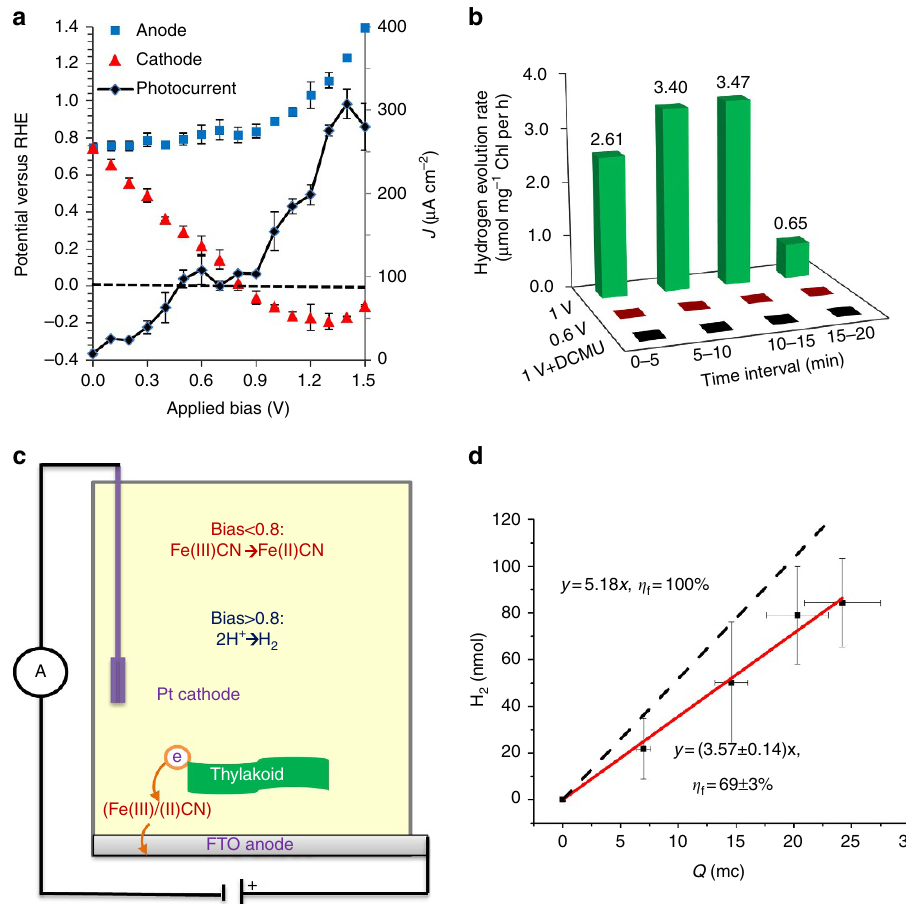
Figure 6 | Two-electrode mode measurements. ( a ) Photocurrent (black curve) and anode (blue squares) and cathode (red triangles) potentials as a function of the applied bias between the anode and cathode. The dashed line represents a potential of 0V RHE . The photocurrent was measured under exposure to solar-simulated light in a cell containing buffer A solution with a thylakoid content of 0.1mgChl and Fe(III)CN concentration of 3mM. The error bars represent the s.d. over three independent measurements ( b ) Hydrogen evolution rate at the cathode under a bias of 0.6V (red bars), 1.0V (green bars) and 1.0V with the addition of 0.5mM DCMU. ( c ) Schematic illustration of the proposed electron transfer pathway in the BPEC cell. When the applied bias is lower than 0.8V the cathode reaction is dominated by cyclic electron transfer of the Fe(III)CN/Fe(II)CN couple, whereas above 0.8V proton reduction to hydrogen prevails. ( d ) H 2 production as a function of the charge that was transferred between the anode and cathode. Dashed black line corresponds to a Faradic efficiency of 100%. The error bars represent the s.d. over four independent